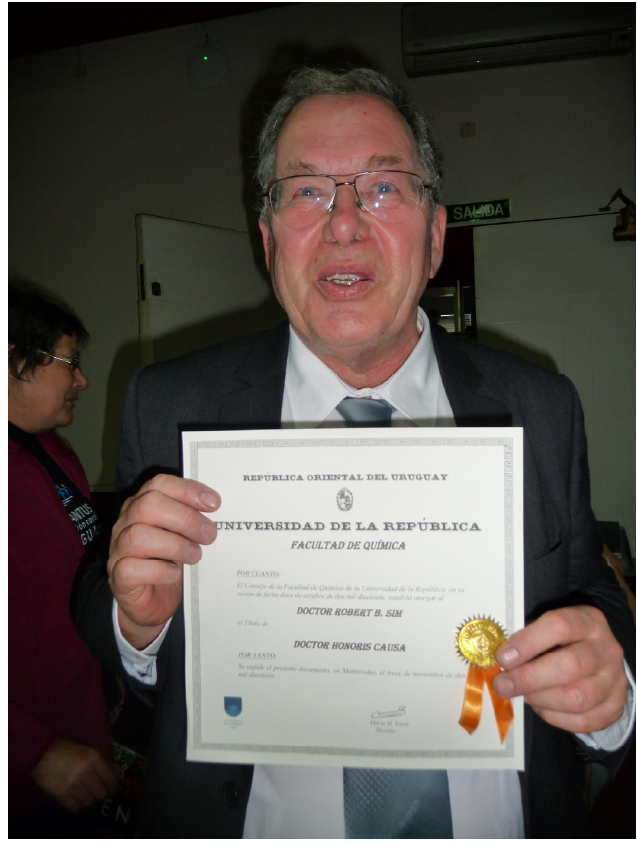
Figure 3. Bob Sim proudly presenting his honorary degree certificate from the Universidad de la Republica Oriental del Uruguay in Montevideo.